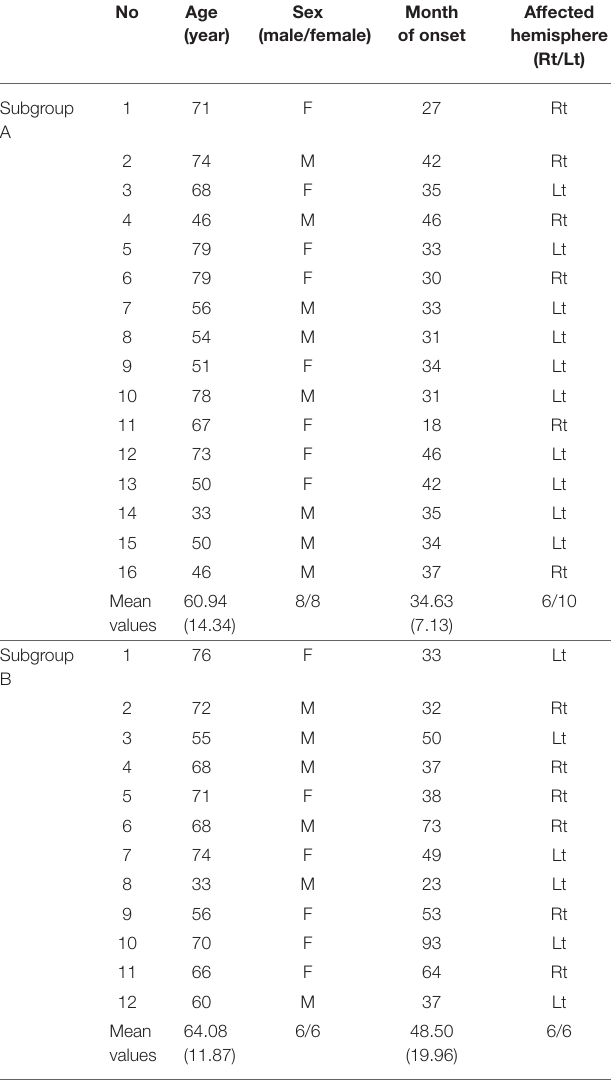
TABLE 1 | Demographic features according to subgroup A and subgroup